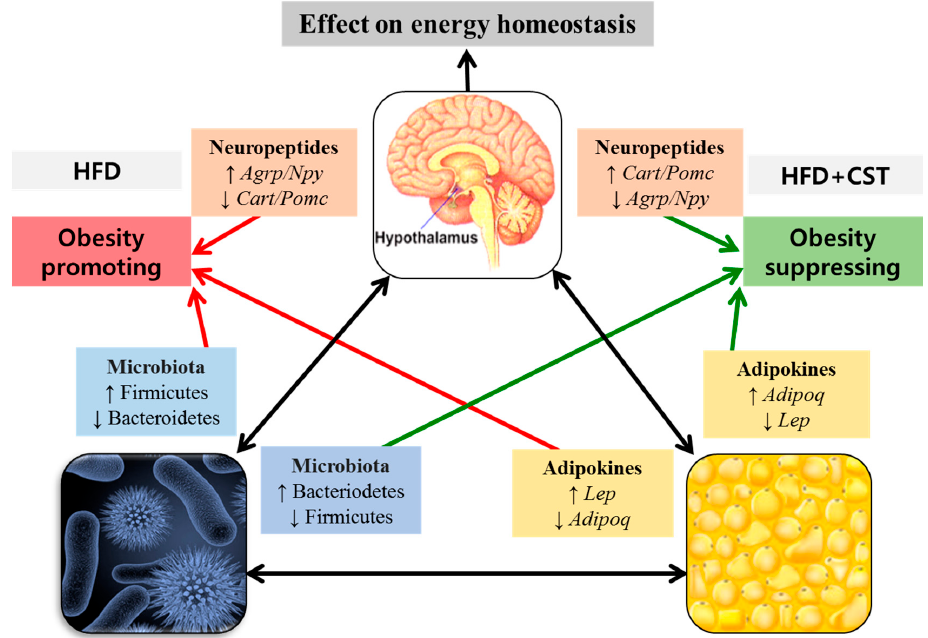
Figure 7. The possible involvement of gut microbial composition in the inter-communication among the vital components of brain-gut-adipose tissue axis associated with host metabolism. The probable interactions between and among the brain-derived neuropeptides, adipose tissue-derived adipokines and the modulated gut microbial communities resulting in the promotion or suppression of obesity are shown. are